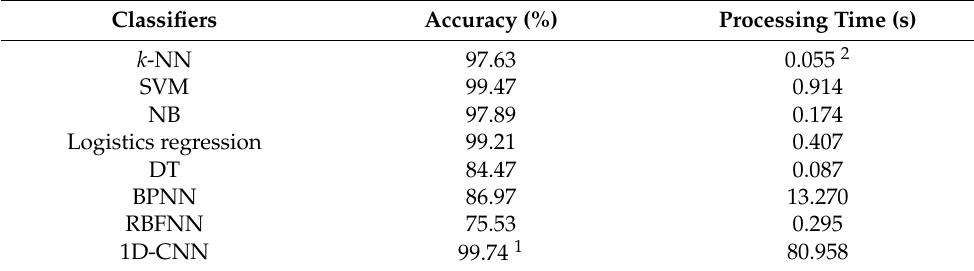
Table 6. Accuracy and processing time of recognizing motions on different